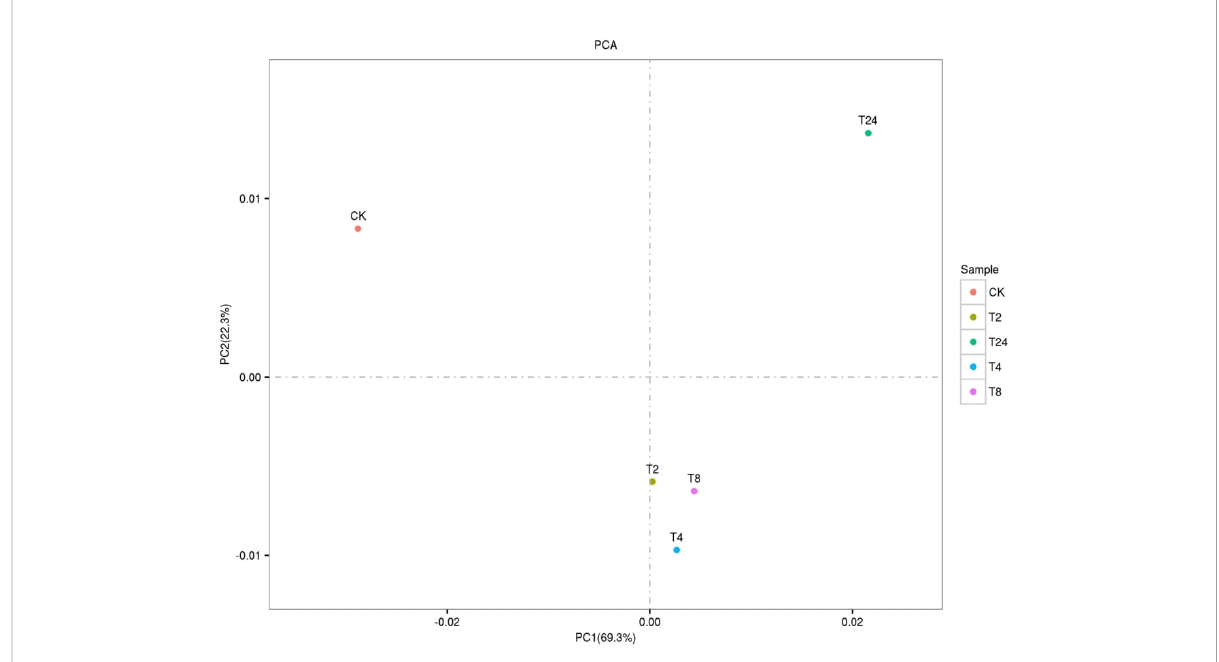
FIGURE 4 PCA two-dimensional coordinate diagram of six samples.